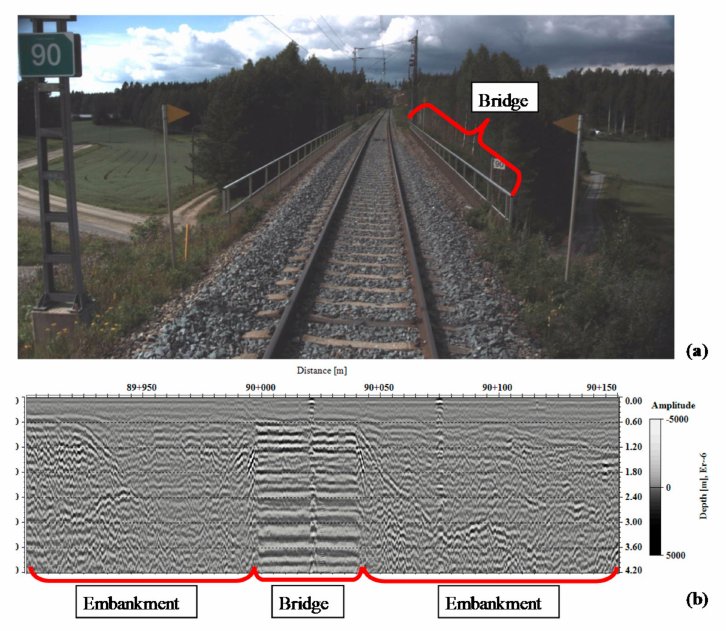
Figure 4. Measurement results: ( a ) the digital video; ( b ) the GPR data.